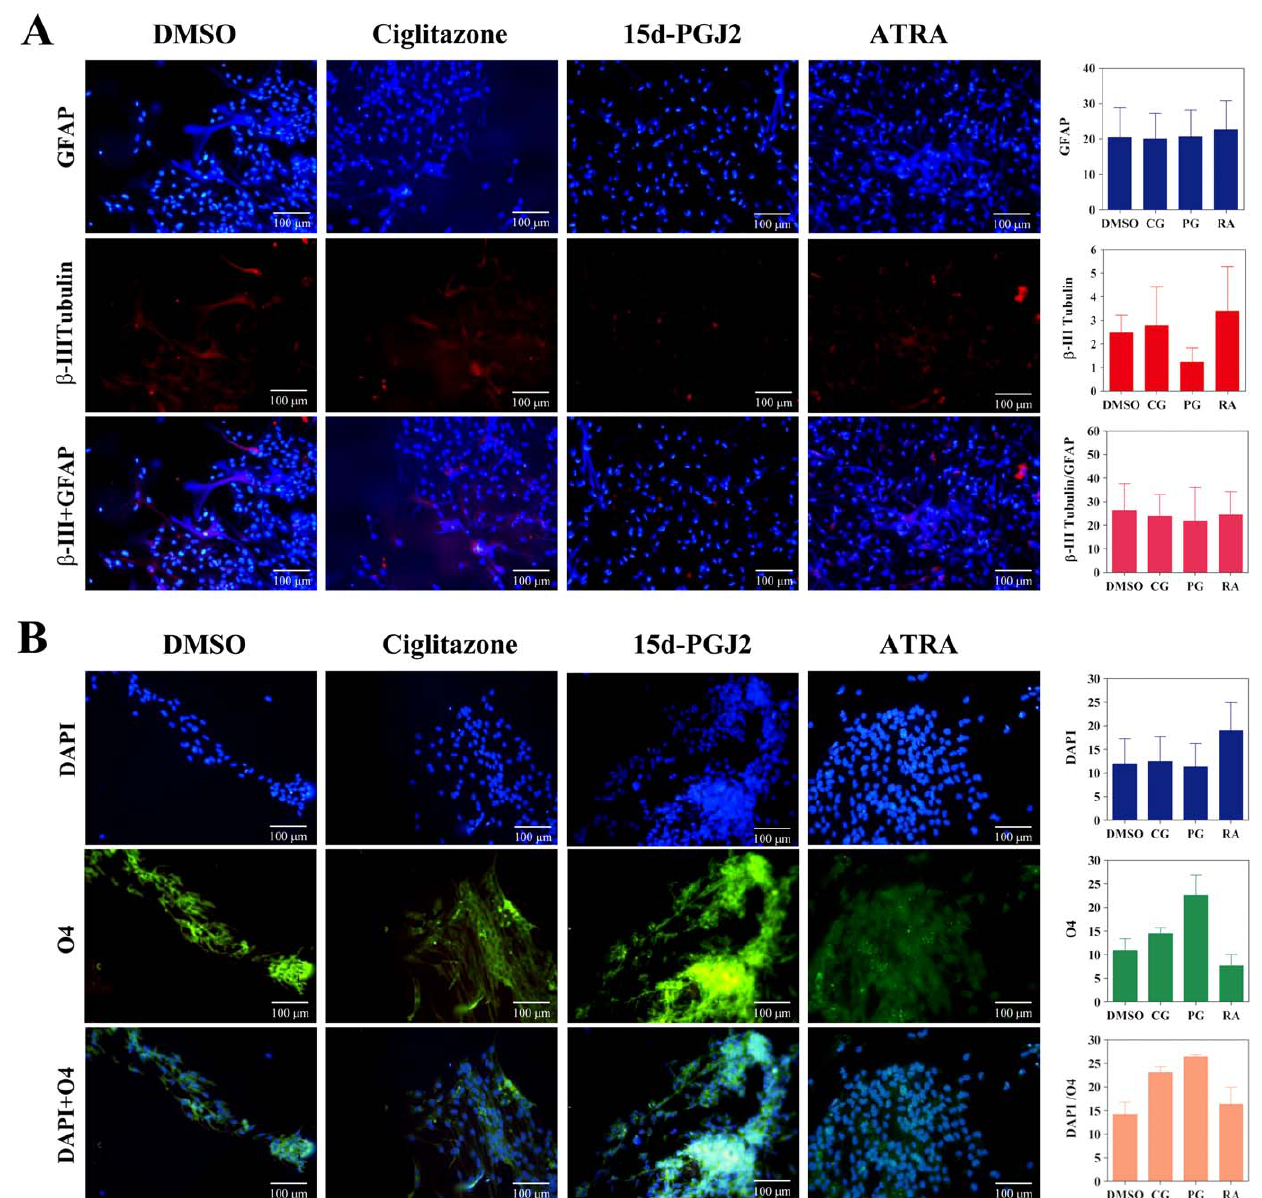
Figure 5. PPAR c agonists induce the expression of oligodendrocyte markers in seven days in NSCs. Neurospheres were cultured in poly- D-lysine coated 8 well chamber slides in NBM + B27 with 10 ng/ml EGF + bFGF in the presence of 0 (DMSO) or 1 m M ciglitazone, 15d-PGJ2 or ATRA. After 7 days the cells were stained with GFAP, b III tubulin, and O4 antibodies along with DAPI and photographed (200 6 ) under fluorescence microscope. The values are mean 6 SEM and the p values are expressed as *(p , 0.05), **(p , 0.01), and ***(p , 0.001). The figure is a representative of three independent experiments.